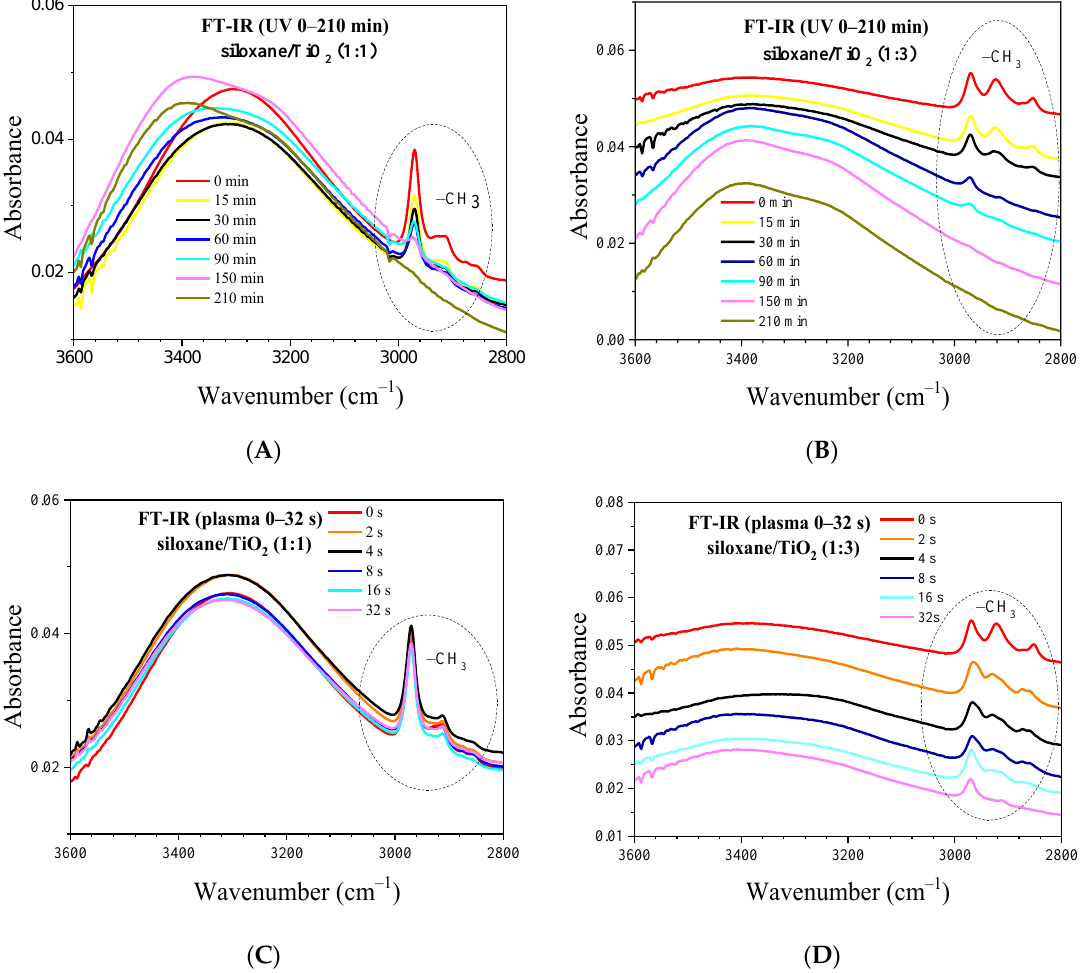
Figure 6. FT-IR measurements of TSC layers. ( A , B ) are images for samples treated with UV-irradiation; ( C , D ) are images for plasma-treated samples. UV-irradiation has better layer penetration and is therefore effective for layers with a higher concentration of siloxane.